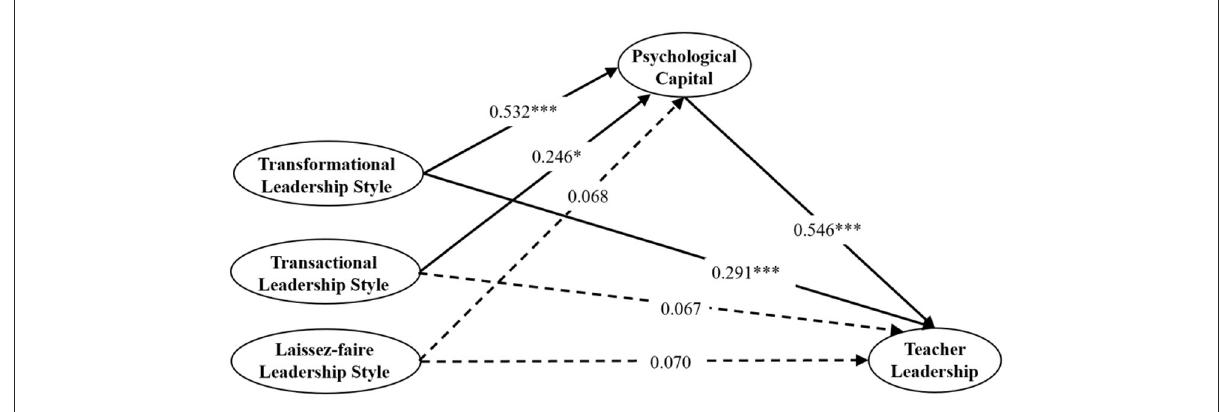
FIGURE2 Psychological capital as a mediator in the associations between principal leadership styles and teacher leadership.* p < 0.05, ** p < 0.01, *** p < 0.001. Dotted lines indicate non-significant paths.